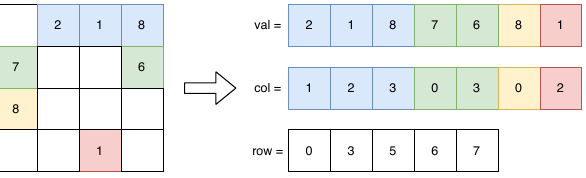
Figure 4. A dense matrix and its representation in CSR format. The row i is in the slice val [ j : k ] , where j = row [ i ] and k = row [ i + 1 ] . The slice col [ j : k ] gives the column of the data.